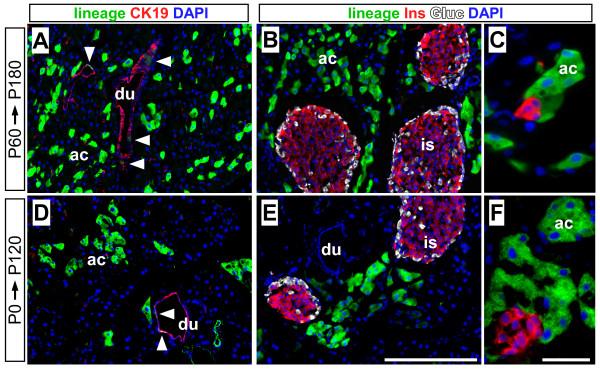
The Muc1 lineage does not contribute to islets after birth. (A-C) Experiment 1: adult Muc1IC2/+; Rosa26EYFP/+ mice (P60) were treated with a single dose of 10 mg tamoxifen, and analyzed after a 120 d chase period (i.e. to six months of age). Immunofluorescence was performed for EYFP lineage label (green), cytokeratin-19 (A, red), insulin (B-C, red) and glucagon (B, white). Lineage label remains restricted to the exocrine compartment (arrowheads indicate labeled duct cells). (D-F) Experiment 2: Muc1IC2/+;  Rosa26LacZ/+ neonates received TM via maternal gavage (sequential 10 mg doses at P0 and P1), and were analyzed after 120 d by immunofluorescence as per A-C (using LacZ, in green, as lineage label). LacZ labeling is confined to duct (white arrowheads) and acinar cells, with no detectable expression in islet cells. Scale bars: A-B and D-E, 100 μm; C and F, 25 μm. Abbreviations: du, duct cells; ac, acini.